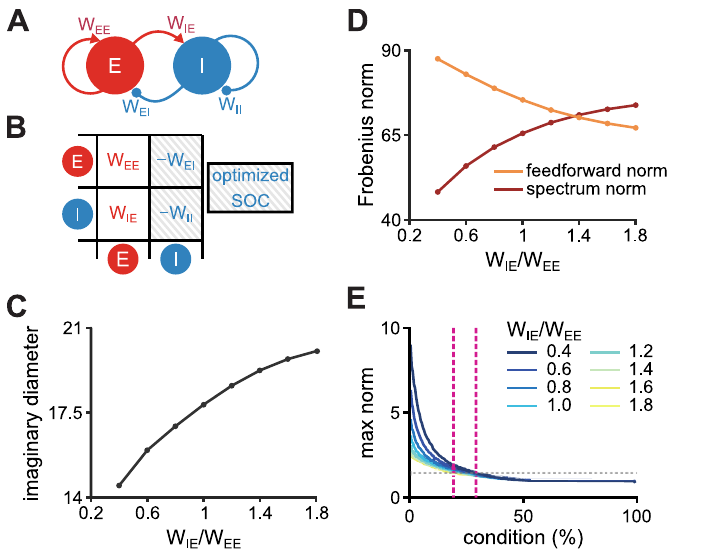
Fig 9. The relationship between E-to-I and E-to-E connectivity strengths alters the imaginary distribution of eigenspectra of Dalean networks. A , Schematics of the mean-field analysis of a network with a group of excitatory (E) and a group of inhibitory (I) neurons. The mean weight from E-to-E, E-to-I, I-to-E, and I-to-I are represented by W EE , W IE , W EI , and W II , respectively. B , Weight matrix of a simplified network from panel A [10]. Inhibitory connections are optimised by the SOC algorithm [8]. C , Imaginary diameter of a network with 100 excitatory and 100 inhibitory neurons as a function of the ratio E-to-I to E-to-E weights. D , Feedforward (orange) and spectrum (red) norm as a function of the ratio E-to-I to E-to-E weights for the same networks from panel C. E , Maximum norm per initial condition for different ratios E-to-I to E-to-E weights. Grey dotted line indicates response norm that is 50% larger than the norm of the initial condition. Pink dashed lines indicate the maximum percentage of orthogonal initial conditions that evoke response norm 50% larger than initial condition for W IE / W EE = 1.8 (lower percentage) and W IE / W EE = 0.4 (higher percentage).